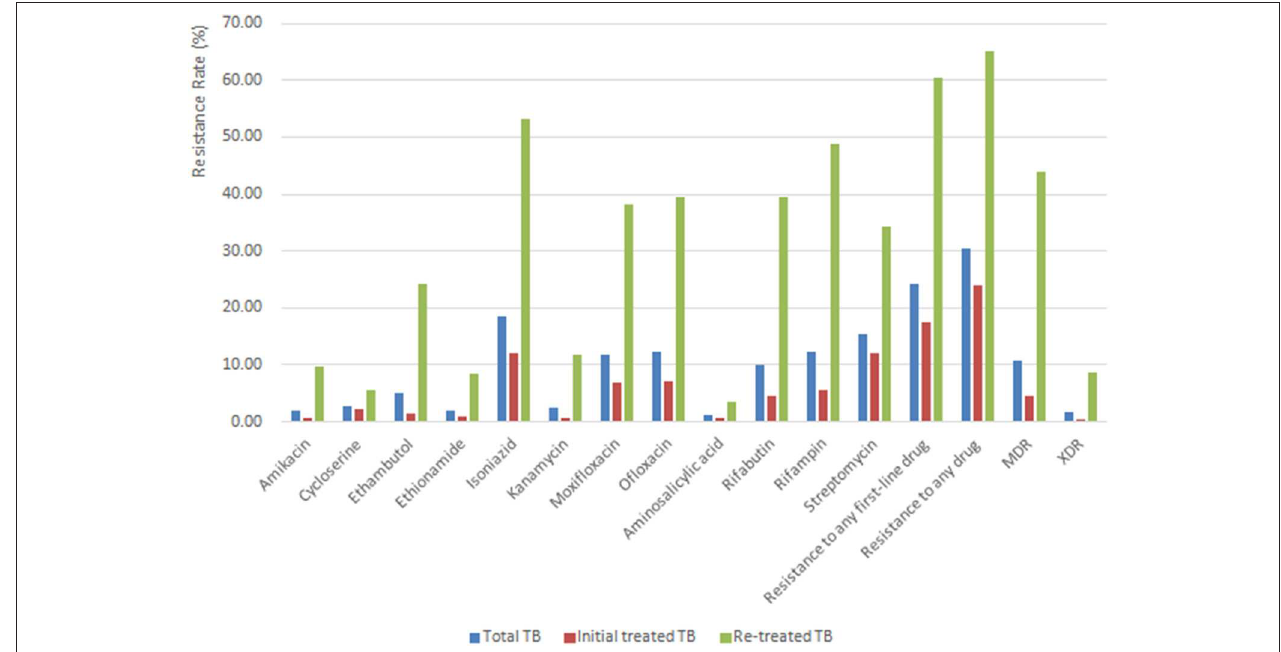
FIGURE 2 | The drug resistance profile of all 1,950 M. tuberculosis isolates.